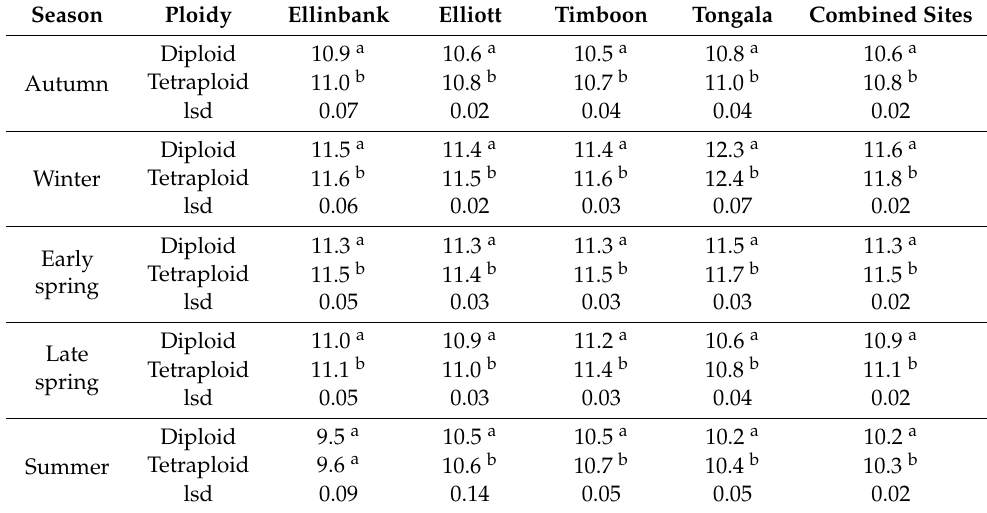
Table 3. Seasonal mean differences in metabolisable energy (MJ/kg DM) across three years between all diploid and tetraploid perennial ryegrass candidates at 4 trial sites in south-eastern Australia. Season Ploidy Ellinbank Elliott Timboon Tongala Combined Sites Autumn